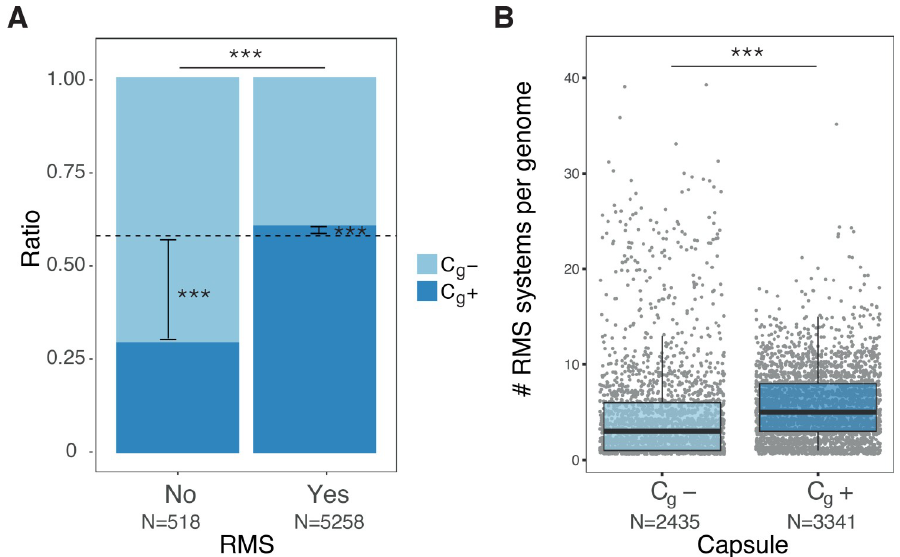
Fig 4. Co-occurrence between capsule systems and RMS systems. A. Presence of RMS systems in genomes with and without capsule system ( χ 2 test, and corrected for genome size with glm ). RMS systems were identified using the highly specific and publicly available HMM profiles in https://gitlab.pasteur.fr/erocha/RMS_scripts. To control for phylogeny we made a complementary analysis restricted to Firmicutes and Proteobacteria. This analysis gave similar results (using BayesTraits, Bayes Factor of 41.3 and 17.2 for Proteobacteria and Firmicutes respectively). Dashed line indicates the ratio of genomes encoding at least one capsule system in the database (57%). B. Number of RMS systems in genomes with and without capsule systems. Correction for genome size was performed as above. Phylogeny was taken into account using GEE (P < 0.0001 and P = 0.1 for Proteobacteria and Firmicutes).